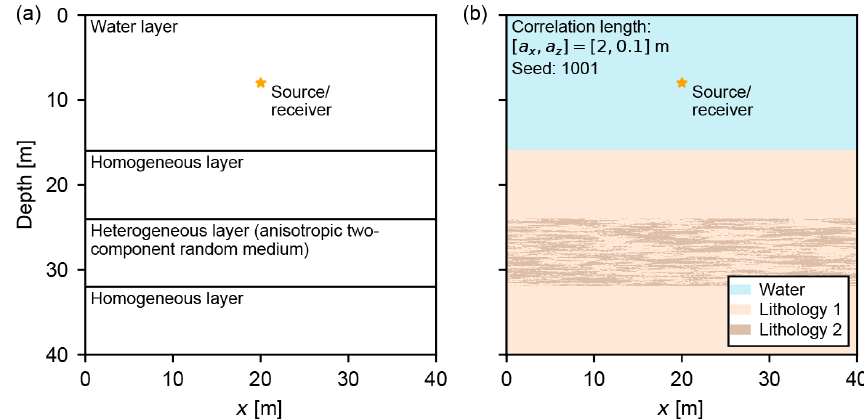
Figure 3. Single-source synthetic experiment. (a) Model geometry. Both homogeneous sediment layers are composed entirely of Lithology 1. The heterogeneous layer is an anisotropic, two-component exponential random medium composed of equal parts Lithology 1 and Lithology 2. Elastic parameters are listed in Table 1. The coincident seismic source and receiver location within the water layer is marked (yellow star). (b) A single realisation of the model showing the spatial distribution of Lithology 1 and Lithology 2 within the heterogeneous layer.